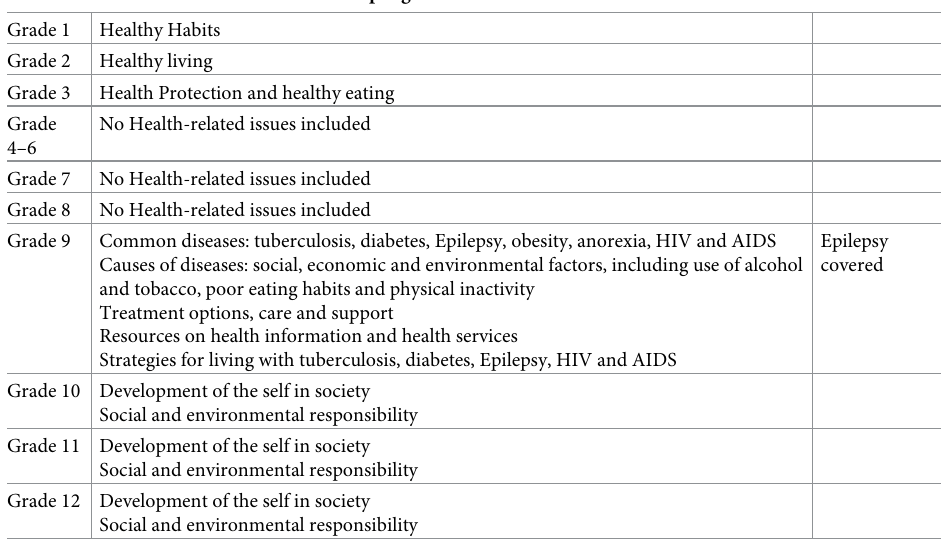
Table 1. Life skill and life orientation focus per